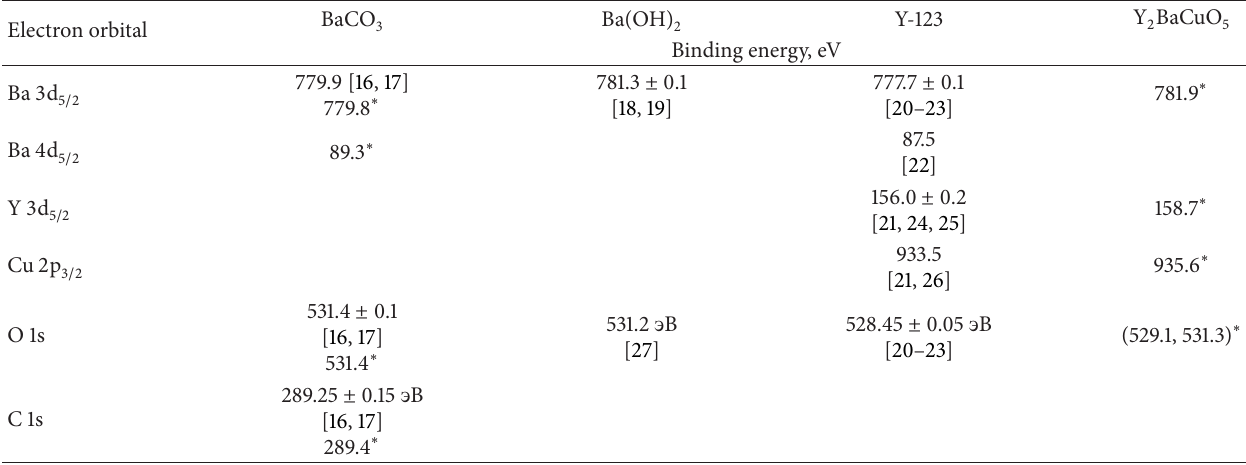
Table 2: The positions of the characteristic XPS lines of barium